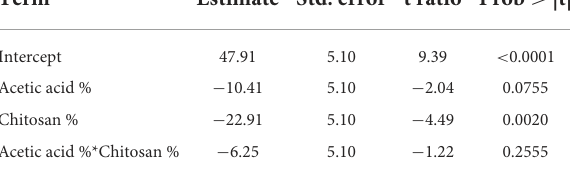
TABLE 5 Mathematical model parameters estimation in the experimental design related to the microbial load of